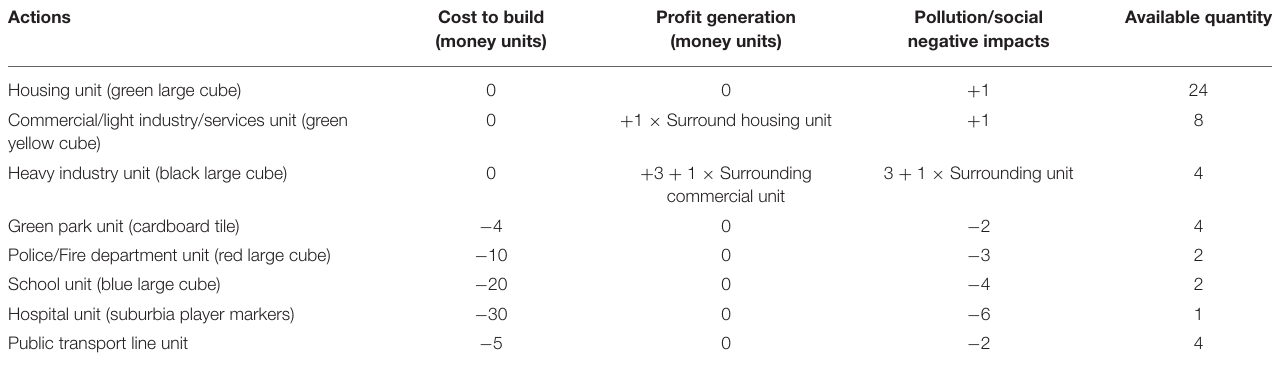
TABLE 1 | Available actions to players during the second game.